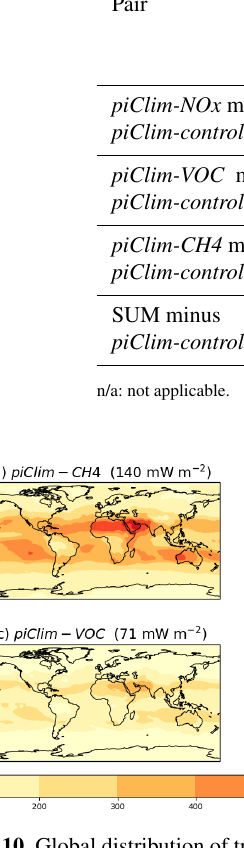
Figure 10. Global distribution of tropospheric O 3 SARF diagnosed from (a) piClim-CH4 , (b) piClim-NOx , (c) piClim-VOC , and (d) their sum relative to piClim-control , based on the diagnosed change in tropospheric O 3 and the tropospheric O 3 radiative kernel of Rap et al. (2015). Global mean values are included. Units in mWm − 2